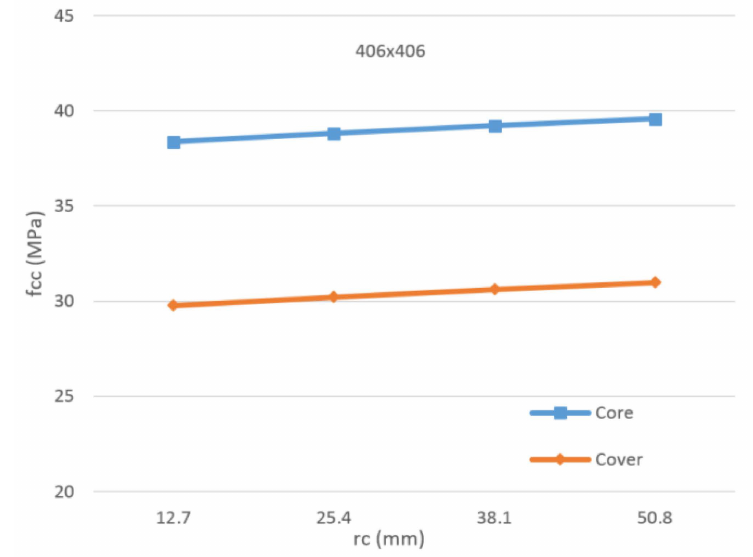
Figure 22. Core and cover confined strengths for the section of 406 ˆ 406